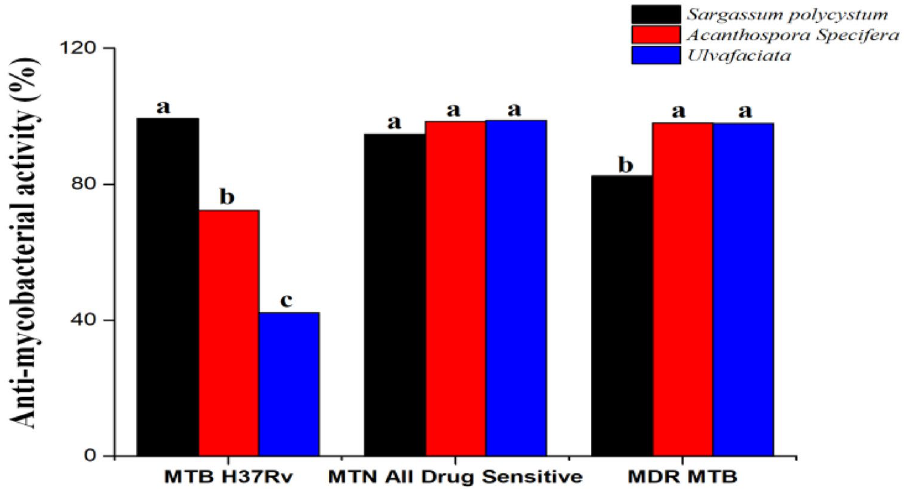
Figure 8. Anti-Mycobacterial activity against silver nanoparticle Seaweeds.